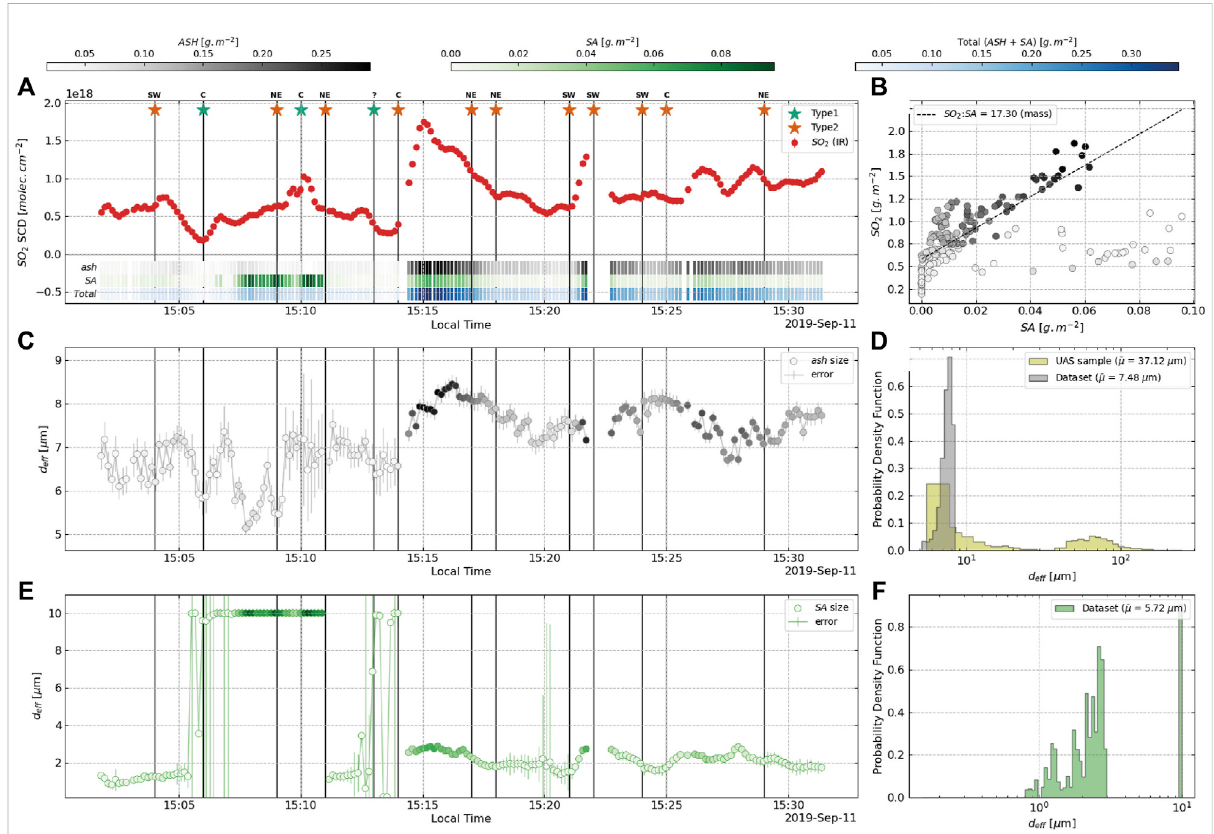
FIGURE 10 Time series of retrieved quantities for a dataset collected downwind on 11 September 2019 (A) SO 2 SCDs [red]. Error bars represent the modelling error only (i.e., the covariance estimated during the linear regression). Stars represent individual events visually documented in the crater area(type1or2),labelledaccordingtotheventfromwhichtheyoriginated(NE:northeast;Ccentral;SW:southwest;?unknown).ThemassSCDsfor ash [grey], sulphate aerosols [SA,green], andthetotal particulates[blue]for each individual measurement are also shown incolour barslocated at the bottom of the plot (colour scales at the top) (B) Scatter plot between SO 2 and SA SCDs, and the linear fi t for this data (SO 2 /SA ratio = 17.3). Individual data points are coloured according to the ash SCD (C) Retrieved effective diameter for ash particle (D) Histogram (N density) of the retrieved sizes over the entire dataset [light grey] weighted according to the ash SCD so that sizes retrieved during ash bursts are represented more heavily. For comparison the particle size distribution measured in the sample collected with the RPAS is also shown [yellow] (E) Retrieved effective diameters for the SA (F) Histogram of the retrieved sizes over the entire dataset [light green] weighted according to the SA